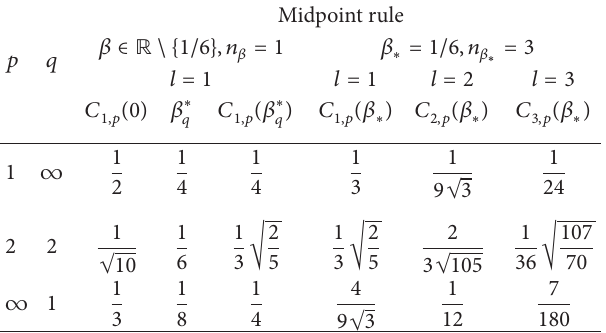
Table 1: Best constants for the midpoint rule.